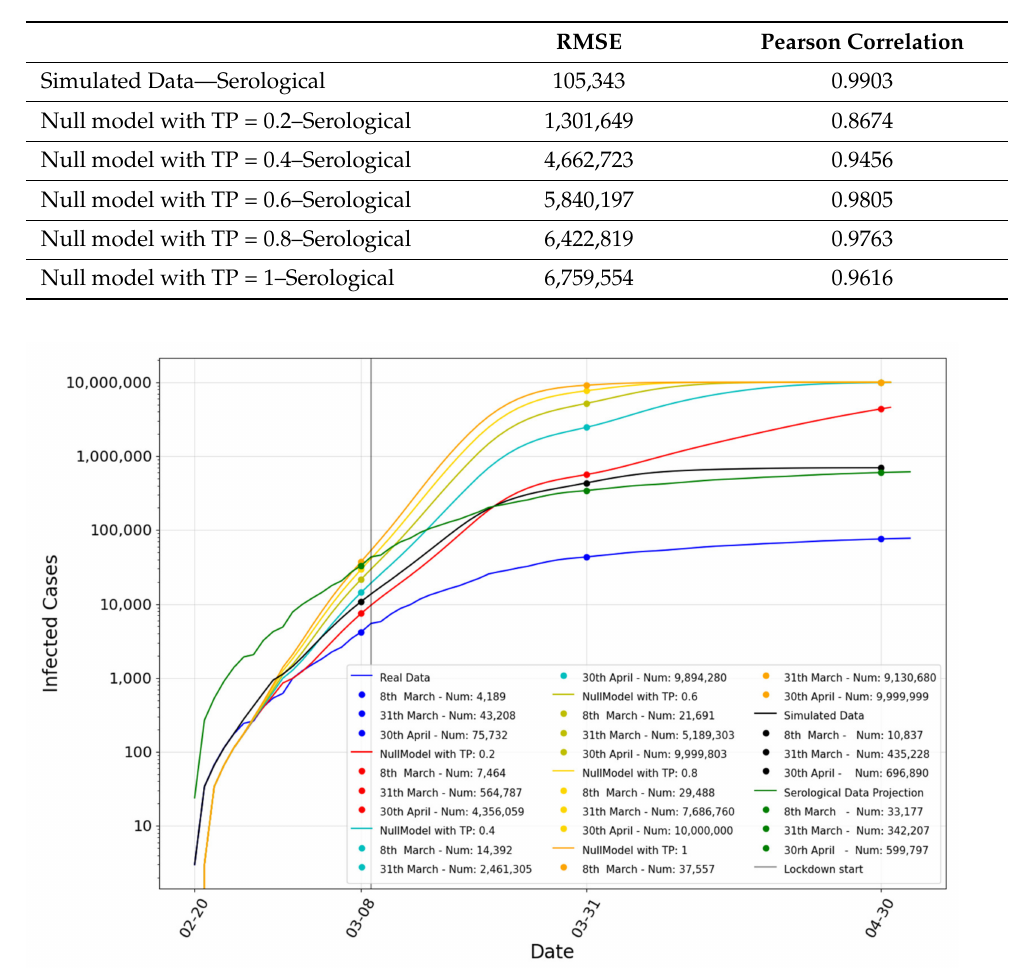
Figure 15. Simulation results without damping parameters with different transmission probability (0.2, 0.4, 0.6, 0.8, 1) (incremental representation—y-axis scale is